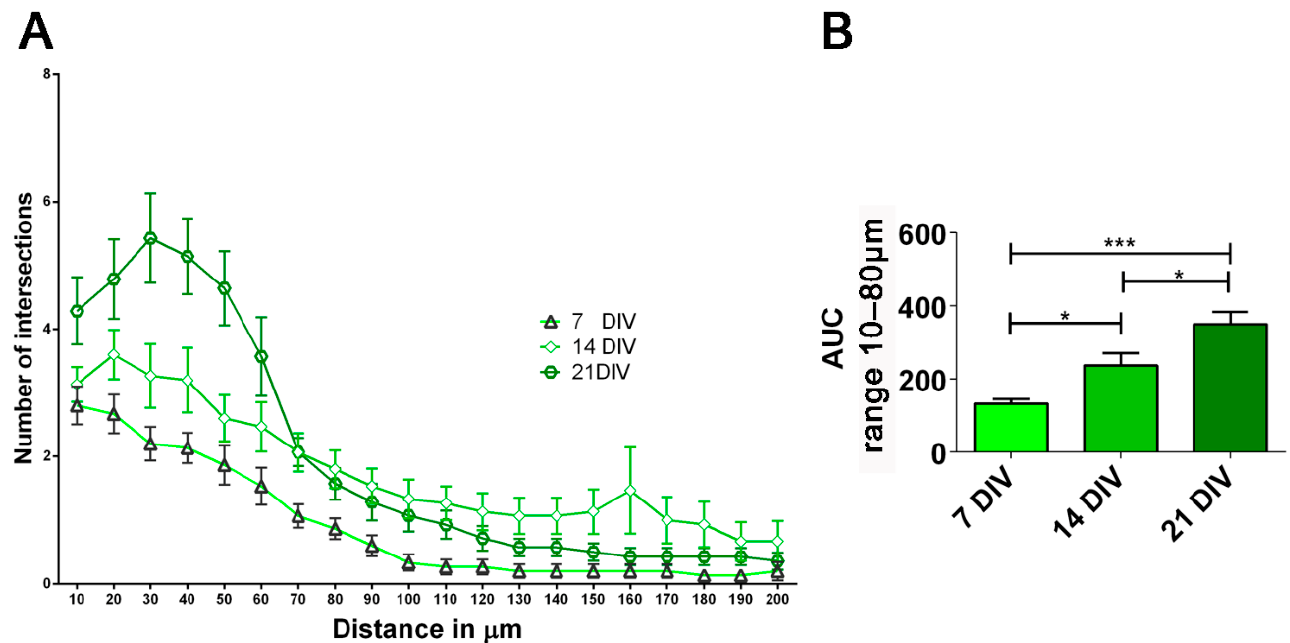
Figure 3. Morphological analysis on hiPSC-derived neurons. ( A ) Sholl analysis showing an increase in branching at the analyzed time points: 7, 14, 21 DIV. ( B ) Area under the curve (AUC) from 10 µ m to 80 µ m graph showing significant increment of dendritic outgrowth at 7, 14, 21 DIV. Histogram values were means ± SEM. * p < 0.05, *** p < 0.001 by one way ANOVA, Bonferroni’s multiple comparisons tests.